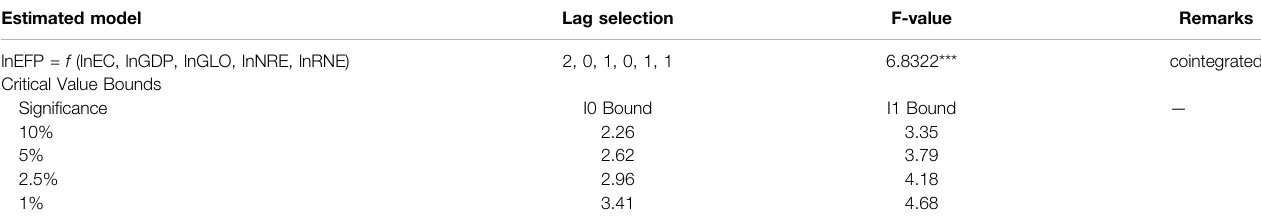
TABLE 6 | Results of bound testing approach. Estimated model